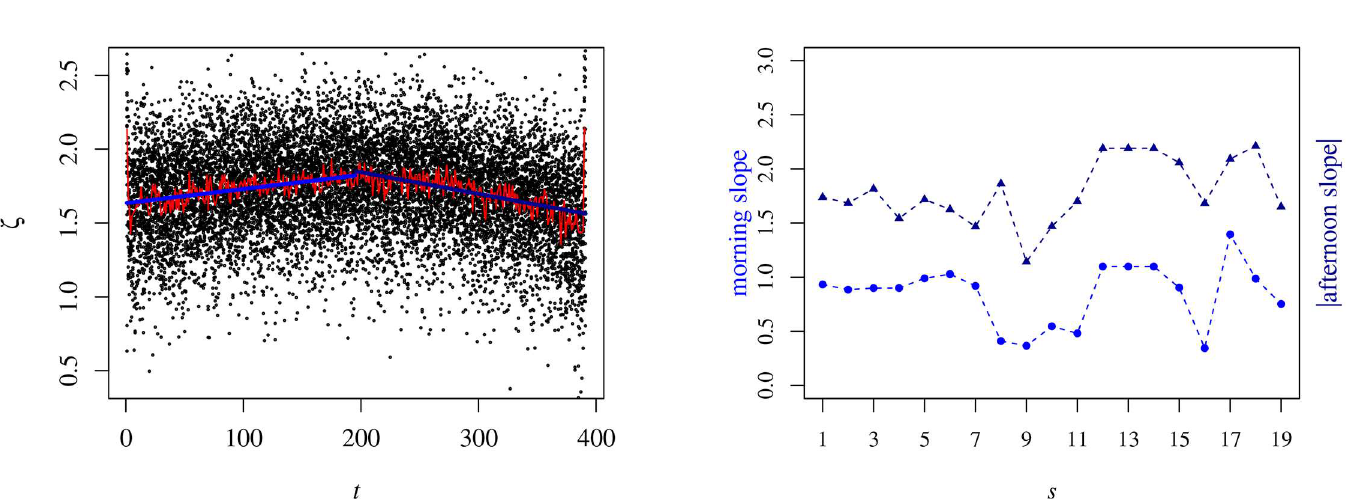
Fig 9. Intraday profile of the skewness during 1S04. Lef panel: The black dots represent the values of ζ i ( t ; 1 S 04), the red line ~ z ð t ;1 S 04 Þ and the ultramarineand navy blue lines corresponds to the linear fit of the red curve for the morning and afternoon parts of the session whose slopes are 10 − 3 ± 10 − 4 and 1.5 × 10 − 3 ± 10 − 4 , respectively. Right panel: The values of the slopes of the fittings as a function of the semester. The ultramarine blue dots represent the morning values ofthe slope and the navy blue triangles the absolute value of the slope in the afternoon part of the trading session.